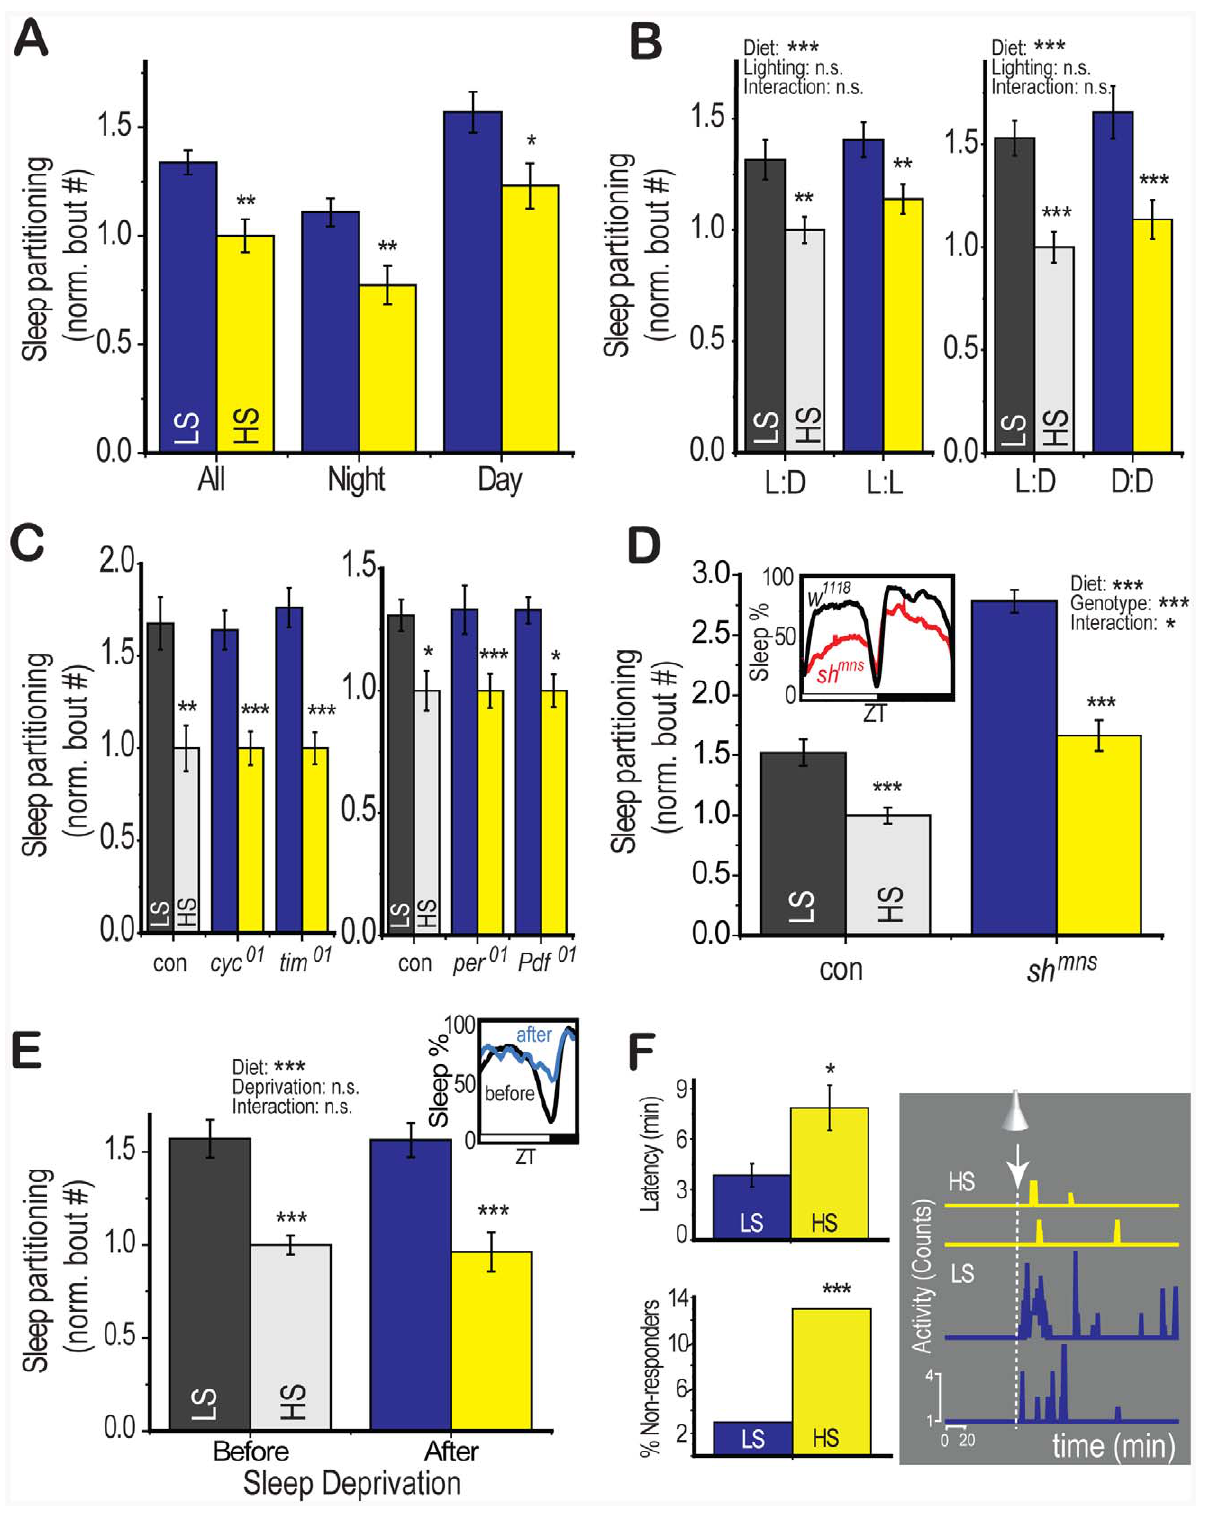
Figure 3. Diet-induced changes to sleep architecture persist despite disruption of circadian rhythm and total sleep. (A) Modulation of dietary sucrose content to 2.5% (LS) or 30% (HS) in a low (2.5%) yeast base increased sleep partitioning during both the day (lights-on) and night (lights-off) period during a 12:12 hour light:dark circadian cycle. (B) Disruption of circadian light cues with constant darkness or constant light for 5 days following a period of 12:12 hour light:dark entrainment did not disrupt the effects of diet on sleep (no significant effect of diet:lighting interaction by two-way ANOVA). (C) Dietary sugar modulated sleep partitioning even in the absence of the circadian clock components cycle ( cyc 01 ), timeless ( tim 01 ), period ( per 01 ), and the circadian neuropeptide pigment dispersing factor ( Pdf 01 ). (D) Mutants containing the shaker minisleep ( Sh mns ) variant showed low total sleep relative to genotype-matched controls (inset). However, the Sh mns flies retained the ability to respond to dietary sugar.